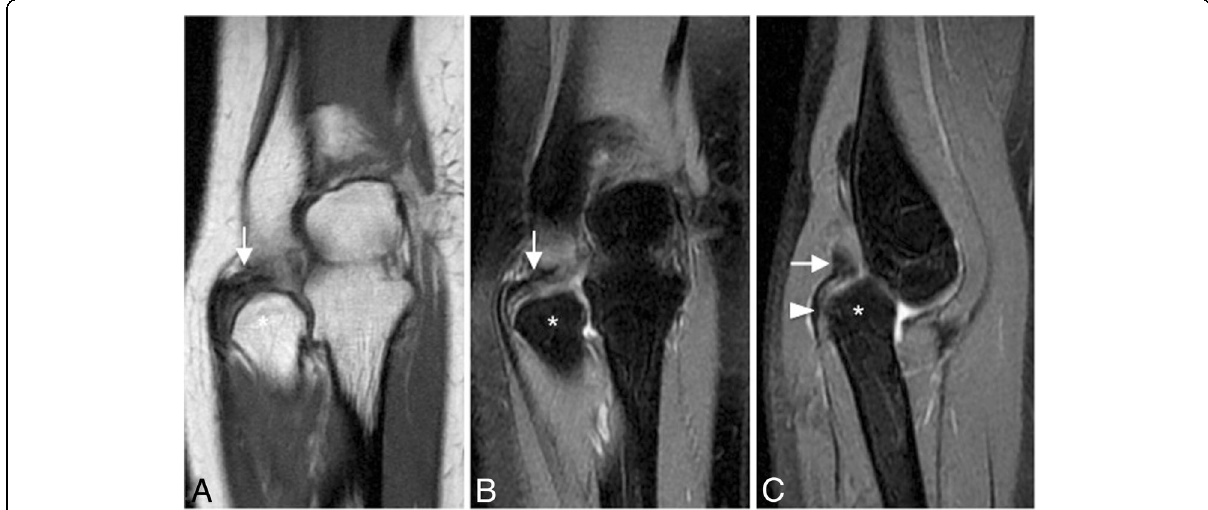
Fig. 33 A 40-year-old man with recurrent painful click in the elbow. Coronal T1-weighted MRI ( a ), coronal FS PD-weighted MRI ( b ), and sagittal FS PD-weighted MRI ( c ) showing a chronic rupture and displacement of the annular ligament (white arrows), dislocation of the radial head out of the annular ligament sling (white arrowhead), and radial head deformity (white